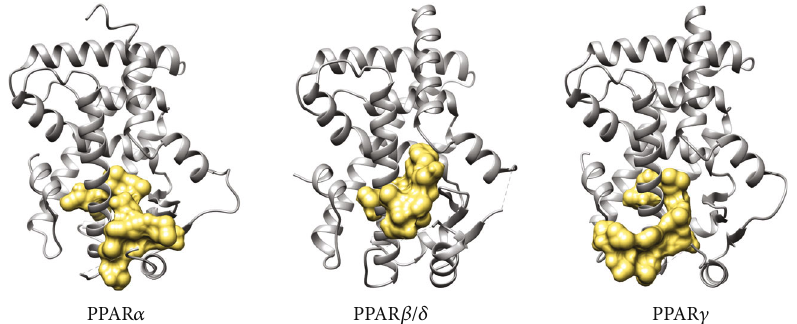
Figure 7: Ribbon diagrams of PPAR α , PPAR β / δ , and PPAR γ (grey) bound to surface diagram of peptide Helix-Y 12 (gold).